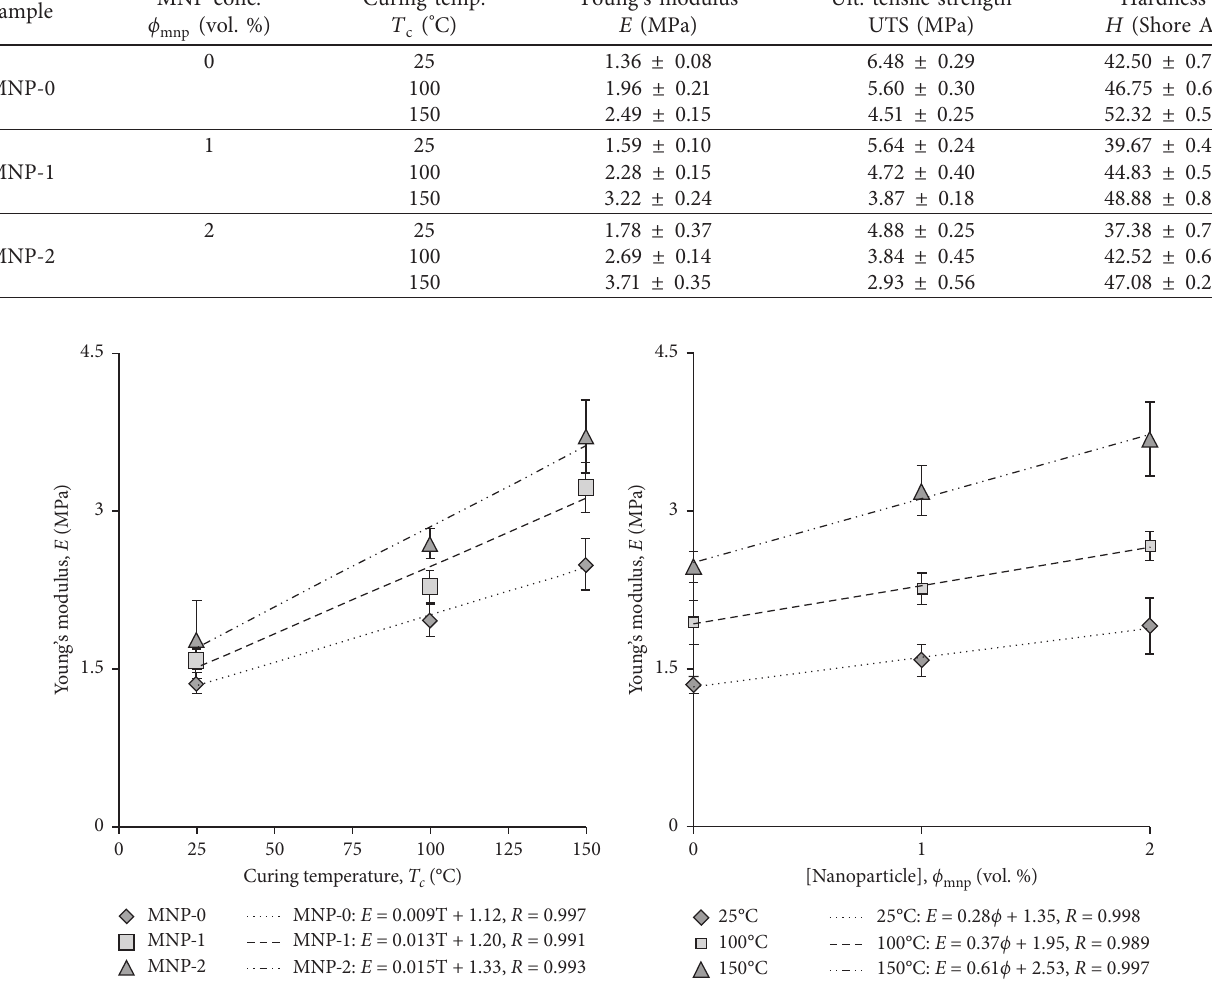
, at different nanoparticle concentrations, ϕ c